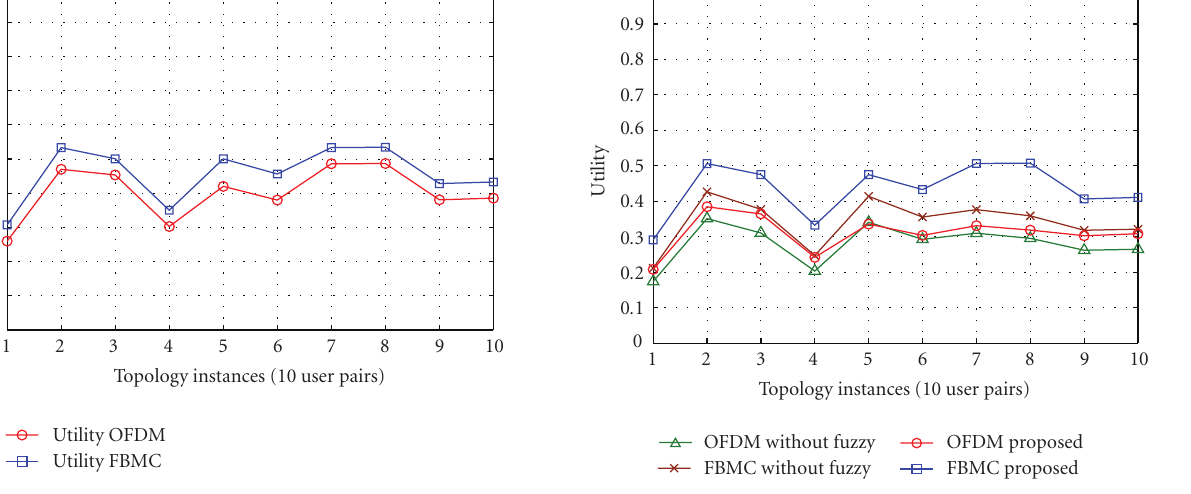
Figure 8: Utility values for the original and the proposed algorithm with both FBMC and OFDM, under the assumption of long message delays (10 user